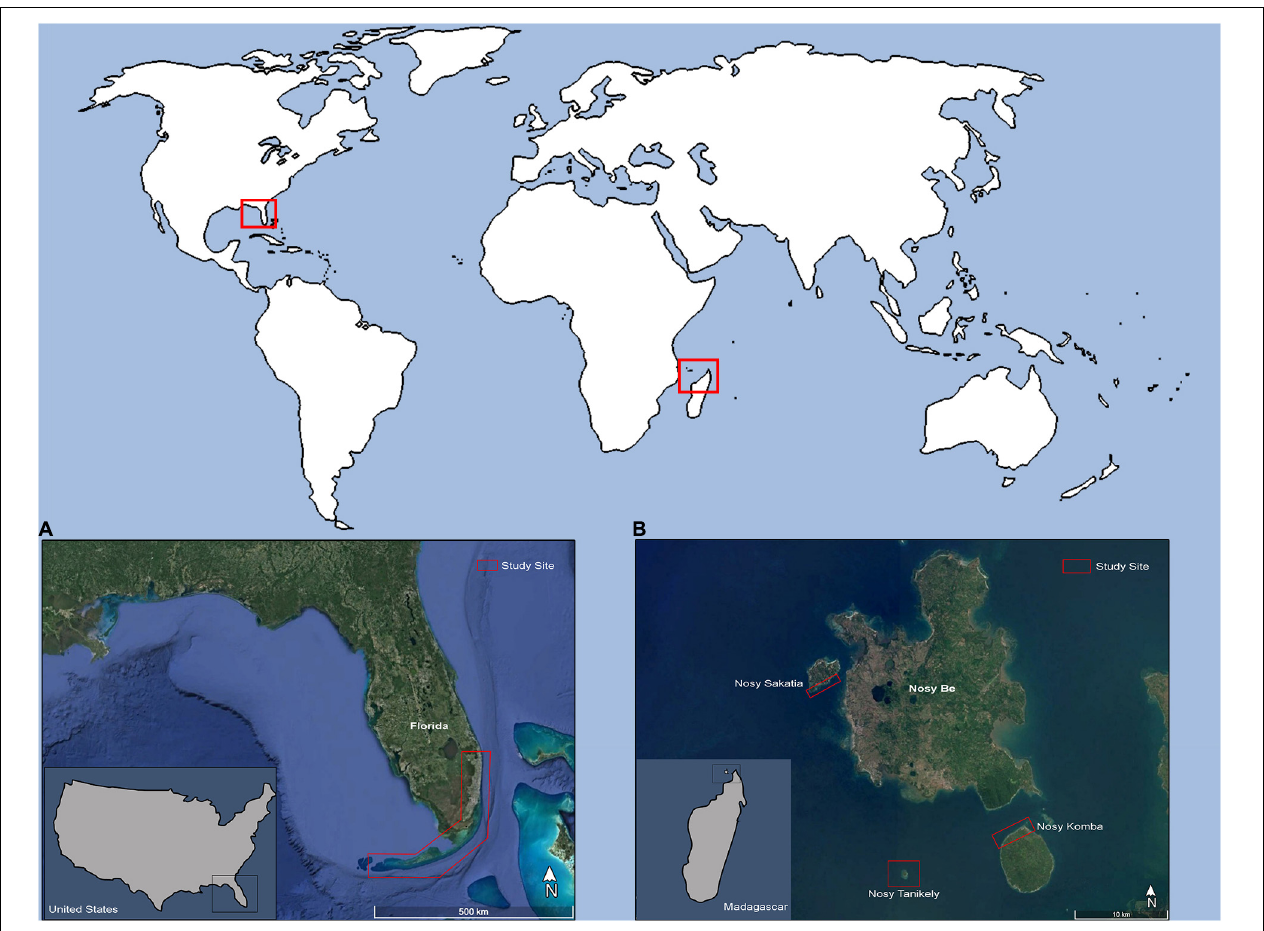
FIGURE 1 | Map of study sites in southeast Florida (A) and Nosy Be, Madagascar (B) .